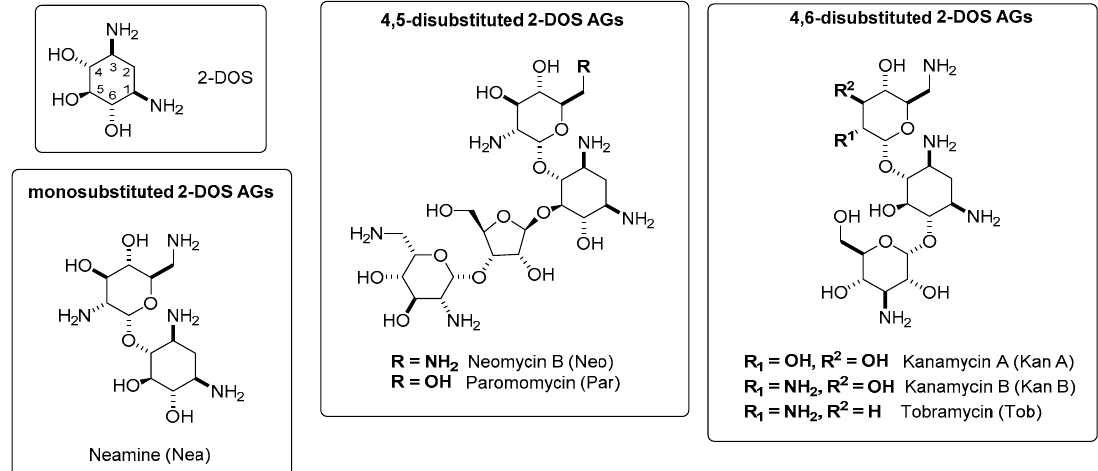
Figure 1. Structures of some aminoglycosides (AGs) discussed in this review.